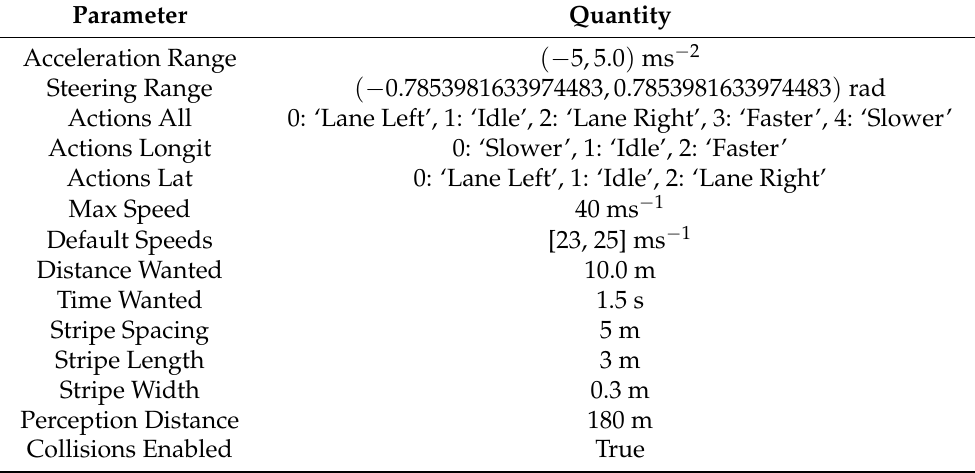
Table 2. Simulation parameters and labels for highway, merging of lanes, and roundabout